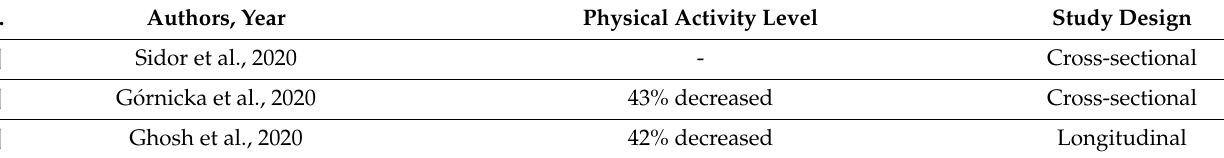
Table 5. Details about reported trends on changes in physical activity level during the COVID-19 lockdown.